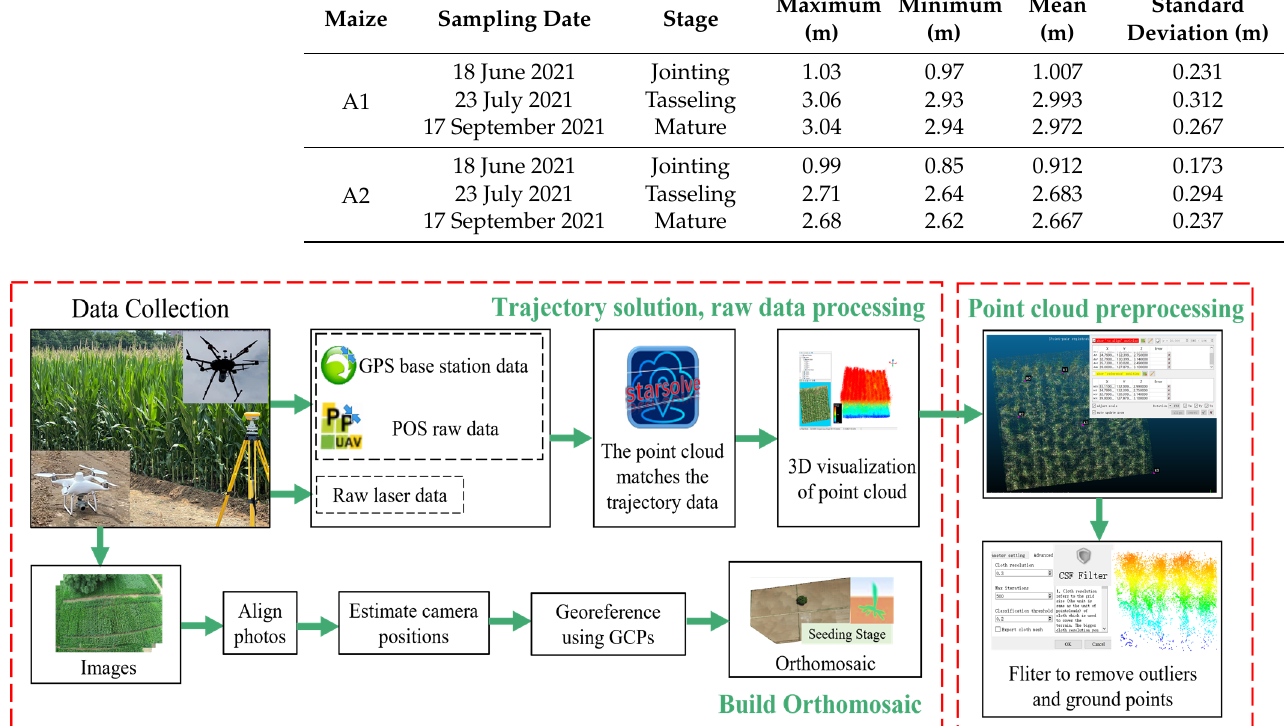
Figure 3. Trajectory solution, raw LiDAR data processing, point cloud data preprocessing, and orthophoto generation.